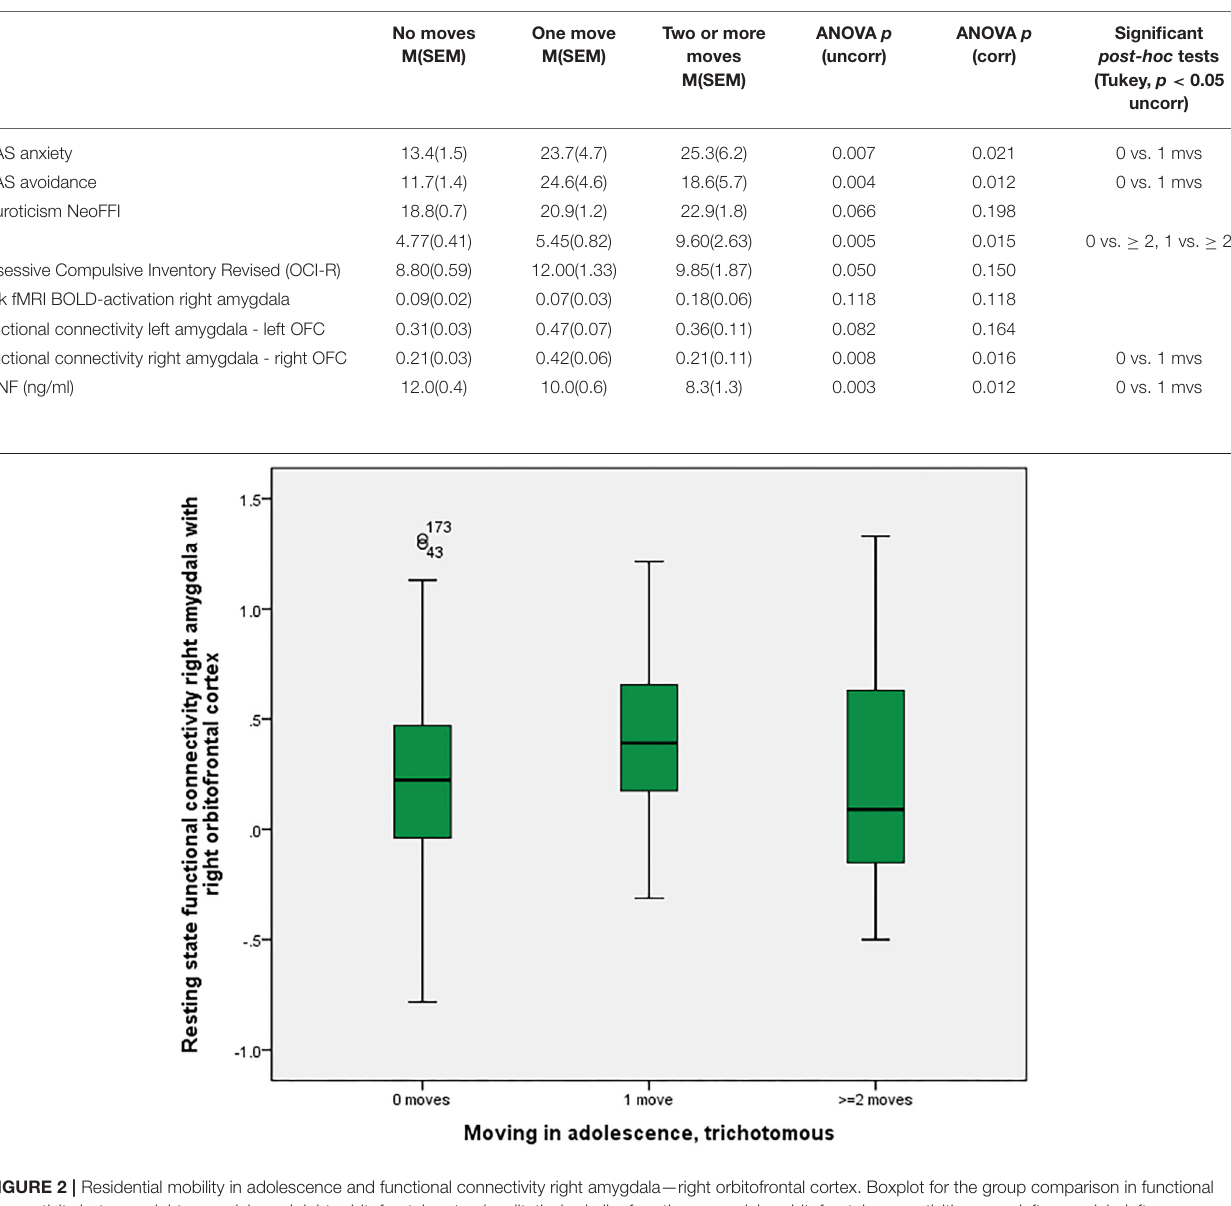
TABLE 2 | Detailed statistics for group comparisons.